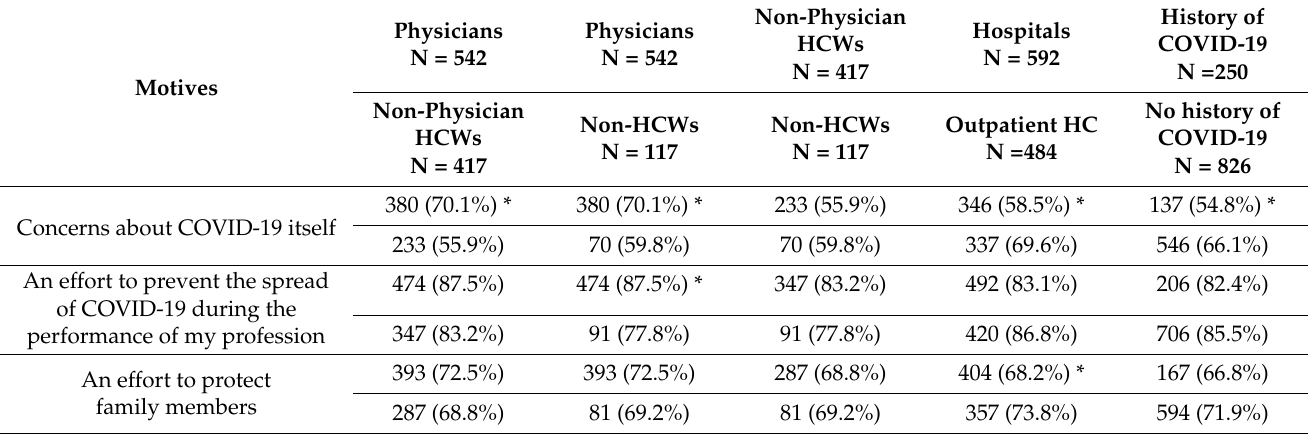
Table 2. Motives to get vaccinated against COVID-19 (vaccinated group, N = 1076) according to selected variables (occupation and history of COVID-19).